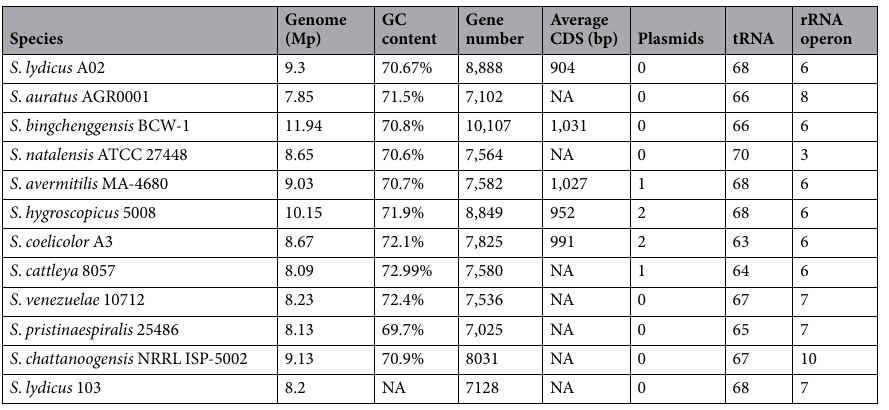
Table 2. Comparison of key genomic features among the twelve fully assembled genomes of Streptomyces